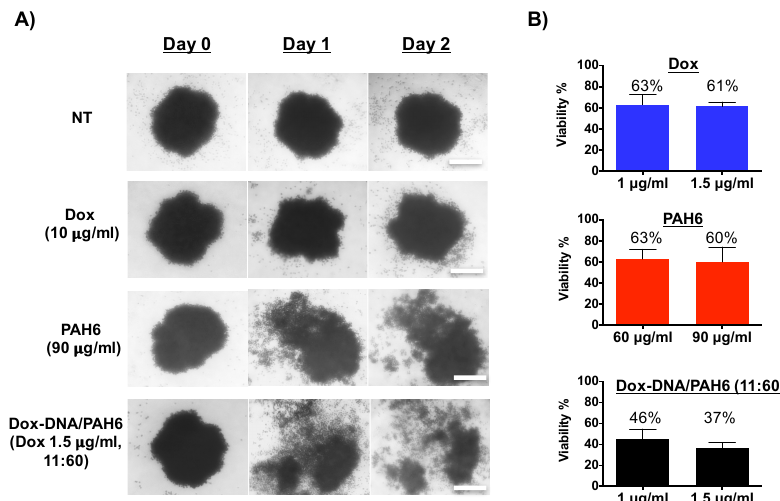
Figure 5. ( A ) Optical micrographs of 3D A549 spheroids treated with Dox, PAH6, and Dox-DNA/PAH6 NC, respectively. The scale bar indicates 260 µ m. ( B ) The cytotoxicity of Dox, PAH6, and Dox-DNA/PAH6 NC against 3D A549 spheroids. Error bars represent SD ( n =